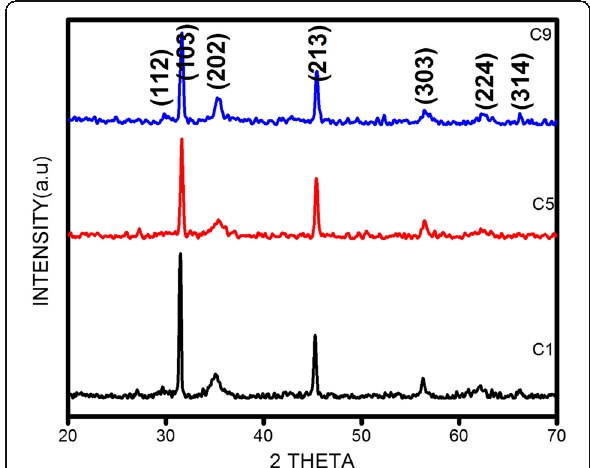
Fig. 1 XRD analysis of Co x Mn y Zn y Fe 2 O 4 (x = 0.1, 0.5, and 0.9 and y = 0.45, 0.25, and